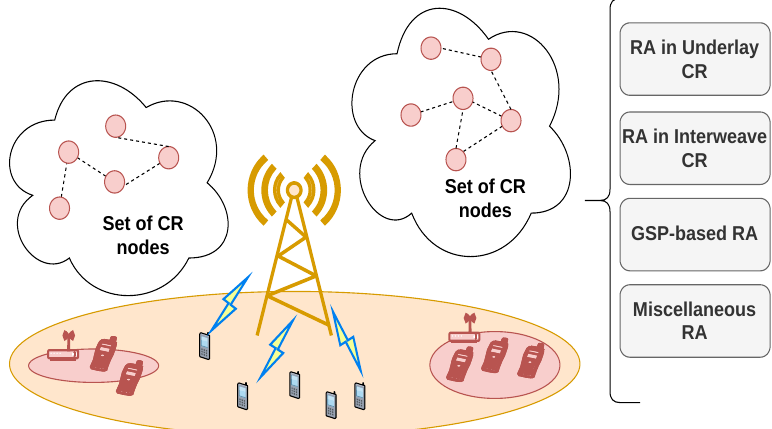
Figure 6. Scenario of CR networks and summary of methods for graph-based